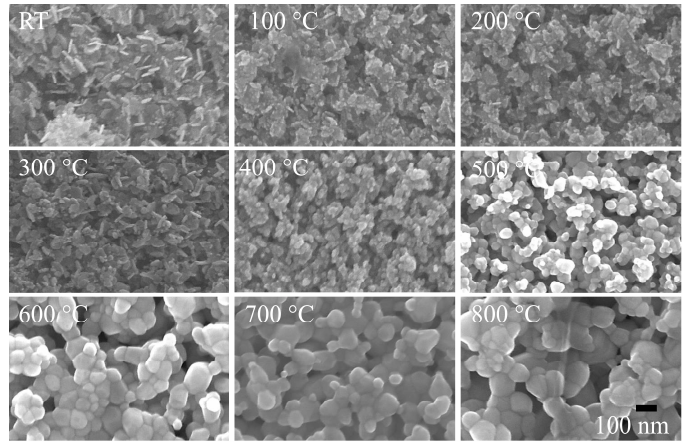
Figure 1. Scanning electron microscopy (SEM) images of RT and 100 °C to 800 °C annealed ZnO/ALO films. (All the images are taken at the same magnification (×10 5 ) with a scale bar of 100 nm shown in the image of 800 °C) films. (All the images are taken at the same magnification ( × 10 5 ) with a scale bar of 100 nm shown in the image of 800 ◦